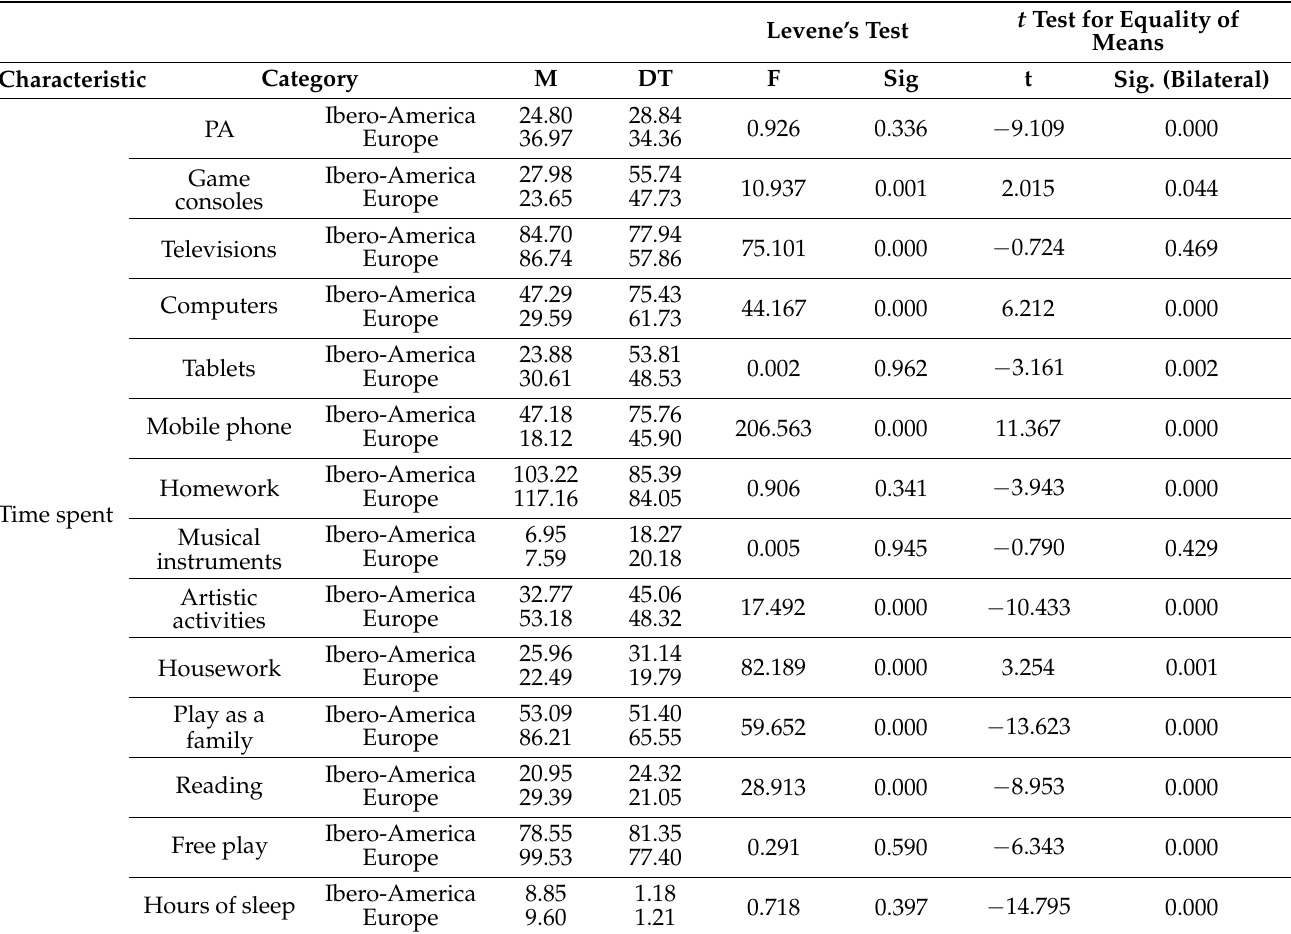
Table 3. Time of use of technological devices and daily actions (expressed in minutes) during confinement as a function of area of residence.